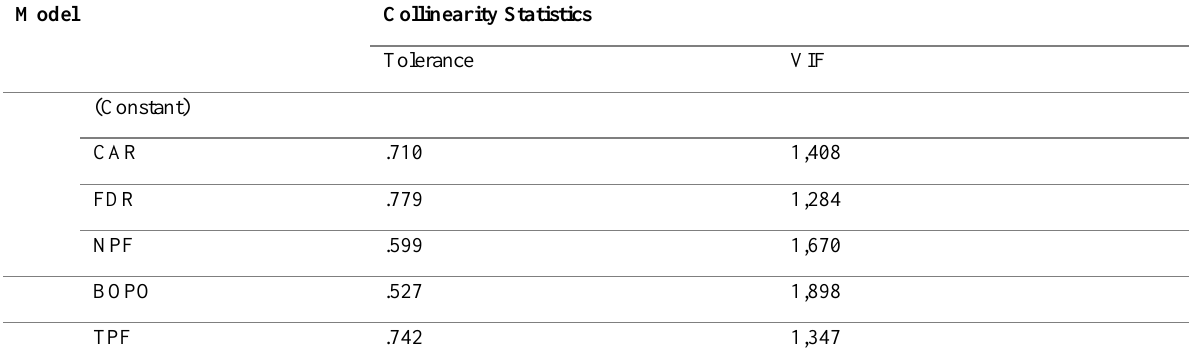
Table 2: Multicollinearity